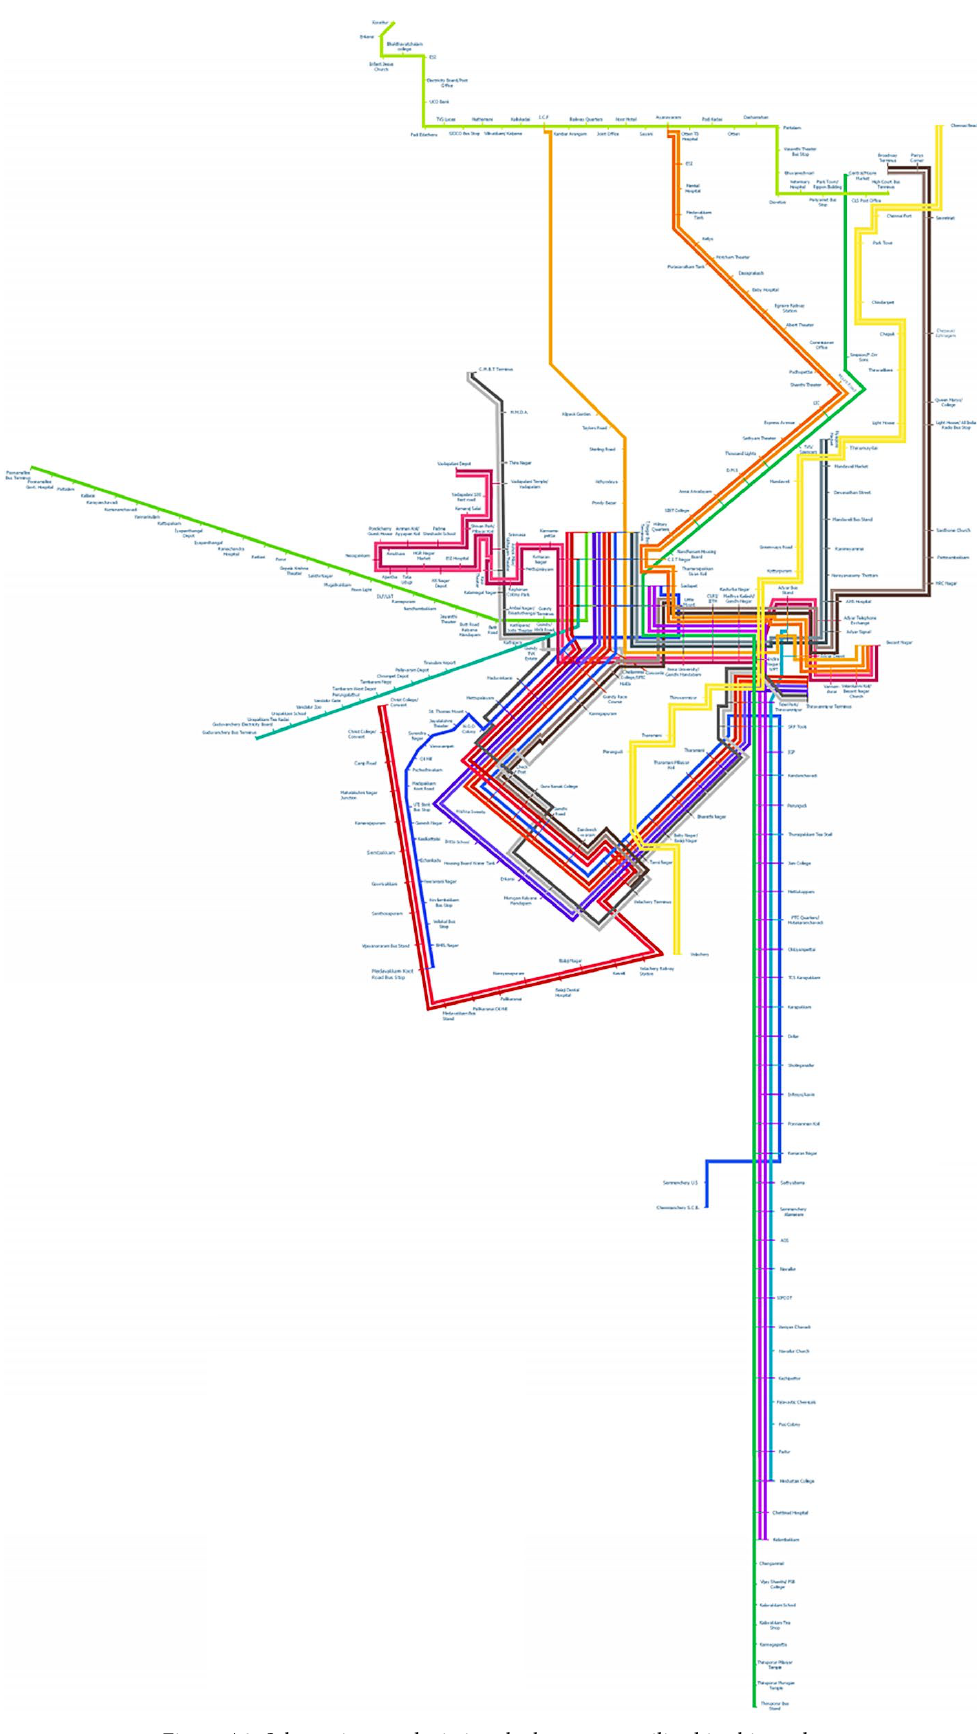
Figure A2. Schematic map depicting the bus routes utilized in this